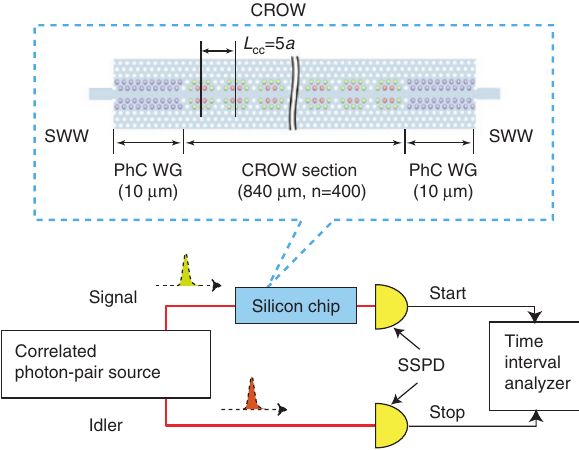
Figure 10: Setup for observing photon buffering. Inset: CROW consisting of PhC